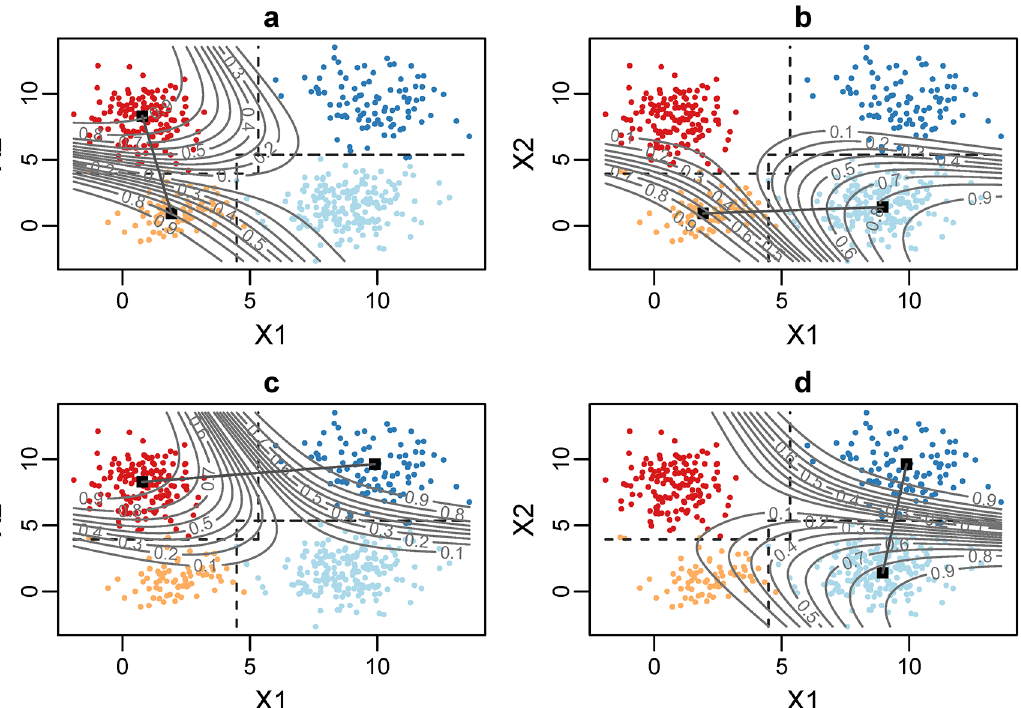
Fig 2. Computation of the delimiters. This is a synthetic example with data drawn from a bivariate ( X 1, X 2) GMM with four components, showing the state of the clustering at the third iteration. Current delimiters are shown as dashed lines. To depict the idea, we defined a grid G over the range of the scatter-plot ð G Þ , w ð G Þ , w ð G Þ , w ð G Þ . We show the contour lines corresponding to the differences in likelihood weight and and we computed the likelihood weights w LL LH HL HH ð G Þ (cid:5) w ð G ÞÞ ; panel b) shows the line the lines connecting the means of the two adjacent clusters: panel a) shows the line ( μ LL , μ LH ) and the contour abs ð w LL LH ð G Þ (cid:5) w ð G ÞÞ ; panel c) shows the line ( μ μ ð w ð G Þ (cid:5) w ð G ÞÞ ; and panel d) shows the line ( μ ( μ LL , μ HL ) and the contour abs ð w LH , HH ) and the contour abs HL , LL HL LH HH ð w ð G Þ (cid:5) w ð G ÞÞ . In each case, we can observe that the delimiter crosses the corresponding line between means at the point with μ HH ) and the contour abs HL HH minimum likelihood difference; panel a) r L . (turn splitting value for low values of speed); panel b) r . L (speed splitting value for low values of turn); panel c) r . H (speed splitting value for high values of turn); panel d) r H . (turn splitting value for high values of speed).